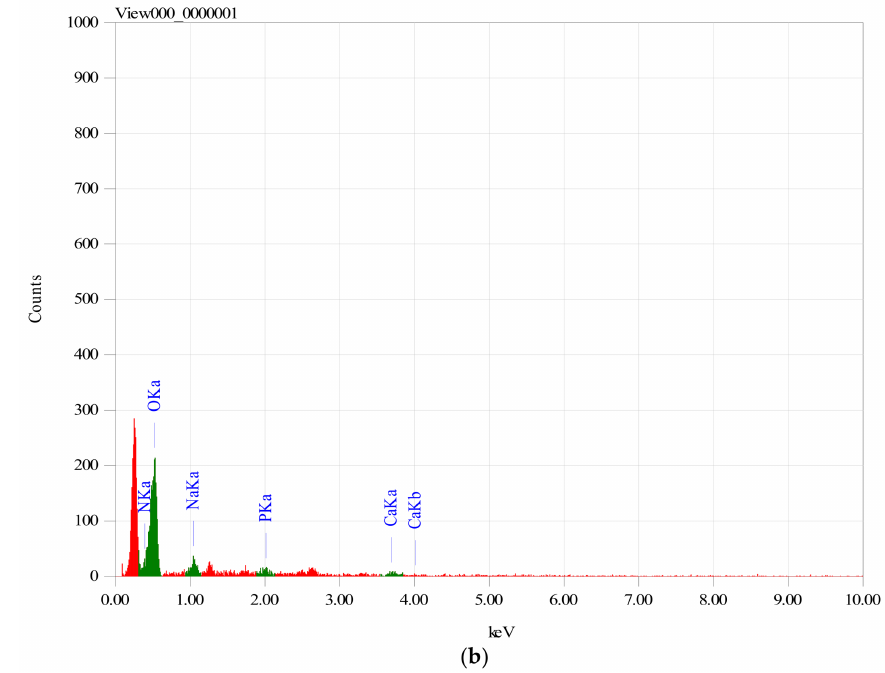
Figure 1. EDX spectrum of ( a ) Ch/HA and ( b ) Ch/HA/MitoQ membranes.